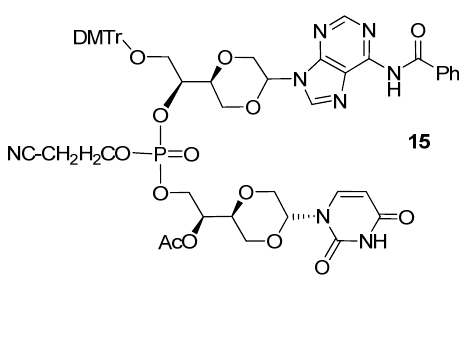
Figure 9. Structure of compound 15